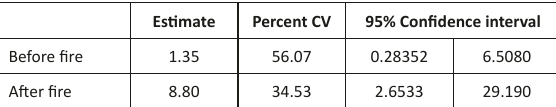
Table 6. Effect of fire on density Estimate